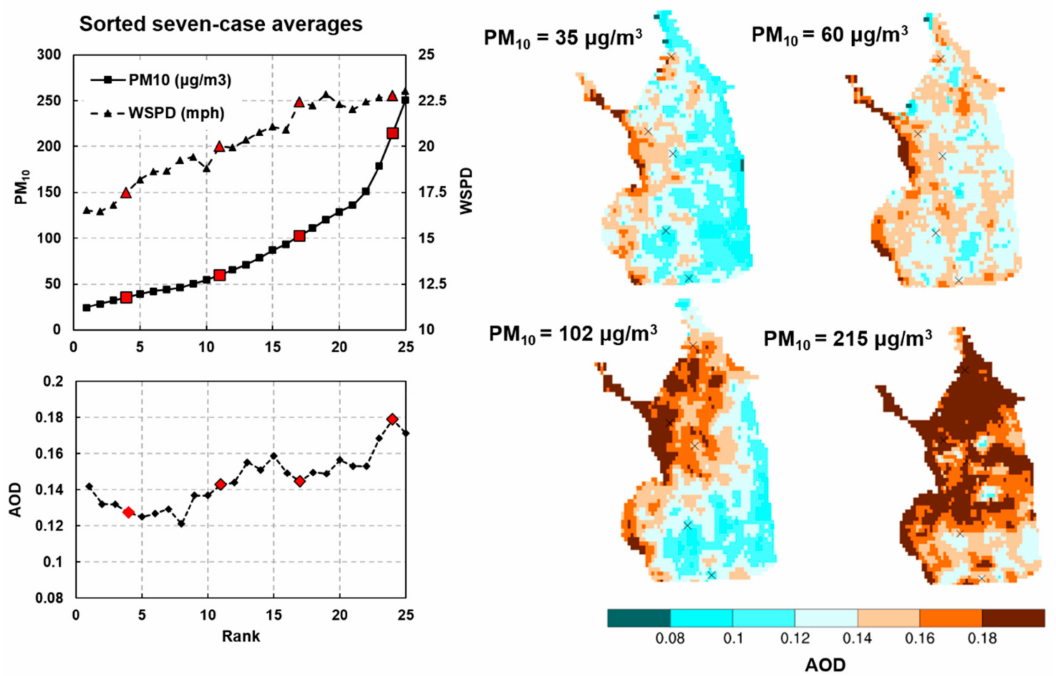
Figure 12. Left : Seven-case running average Brawley-Niland PM10 concentrations for events comprising the WSW set, sorted lowest to highest(solid-squares, upper left ), and corresponding seven-case running averages for average wind speed at KIPL (dashed-triangles, upper left ) and valley-averaged AOD (dashed-diamonds, lower left ). Right : spatial plots of seven-case running average AOD fields for four representative points on left-hand plot of successively higher PM10 indicated by red, larger symbols on the left panel. The ”x” symbols on right panel are the locations of routine PM10